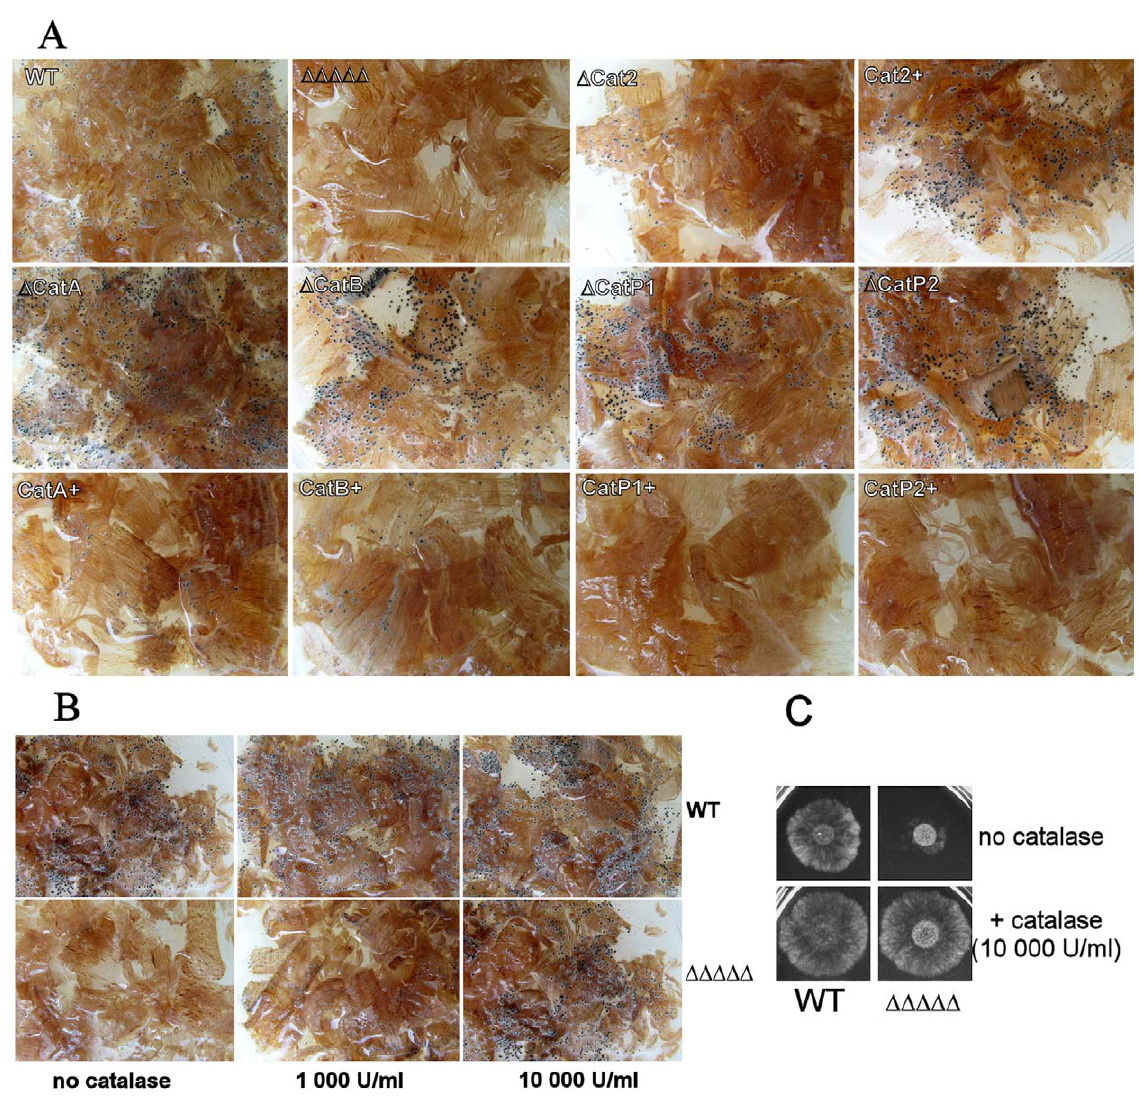
Figure 4. Phenotypes of wild type and catalase mutants on medium with wood shavings. ( A ) Mycelia of the single, quadruple and quintuple catalase mutants and wild type (WT) were inoculated at the center of the plate. After seven days of growth at which time the pictures were taken, WT differentiated perithecia (small black dots). The quintuple catalase ( DDDDD ) mutant differentiates no fructification. The D Cat2 single mutant strain differentiated fewer perithecia than WT and with a delay of 24 H, as evidenced by the smaller size of the perithecia. All the other single mutants ( D CatA , D CatB , D CatP1 and D CatP2 ) differentiated more fructification with 12 H of advance (seen by their larger size) in comparison to WT. The CAT2 + quadruple mutant ( D CatA D CatB D CatP1 D CatP2 ) showed a phenotype similar to WT. The other quadruple catalase mutants (CatA + : D CatB D Cat2 D CatP1 D CatP2 ; CatB + : D CatA D Cat2 D CatP1 D CatP2 ; CatP1 + : D CatA D CatB D Cat2 D CatP2 ; CatP2 + : D CatA D CatB D Cat2 D CatP1 ) differentiated less perithecia than the WT with delays of variable length. CatP1 + and CatP2 + perithecia are produced after nine day of growth and are not seen at seven day. (B) DDDDD and WT were inoculated at the center of the plate in presence of 0, 1000 or 10 000 U/ml of bovine catalase. As in A, pictures were also taken at seven days of incubation. (C) DDDDD and WT were inoculated on solid medium with lignin as sole carbon source without bovine catalase (Top) or with 10 000 U/ml of bovine catalase (bottom). The picture was taken after two days of growth.